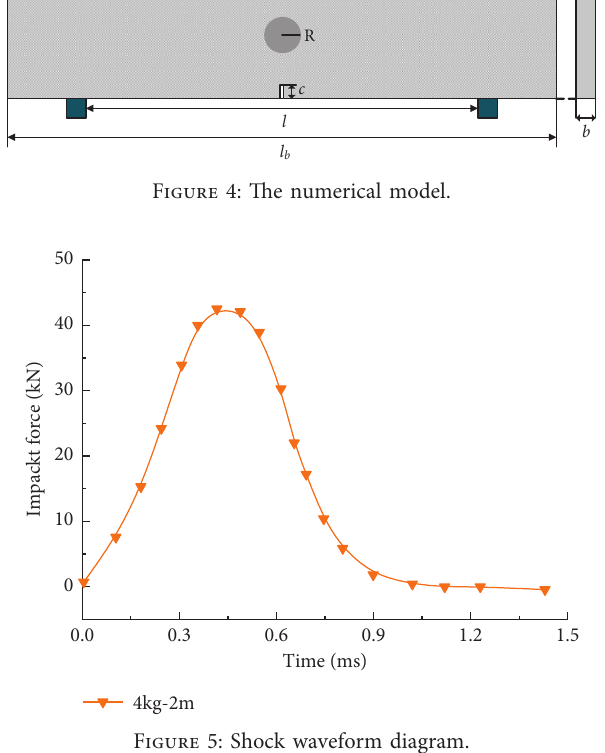
Figure 5: Shock waveform